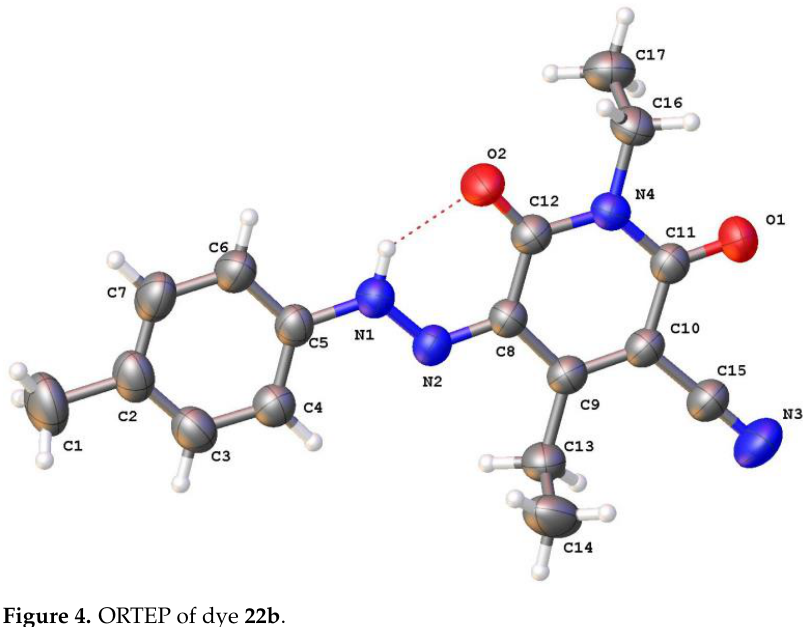
Figure 4. ORTEP of dye 22b .